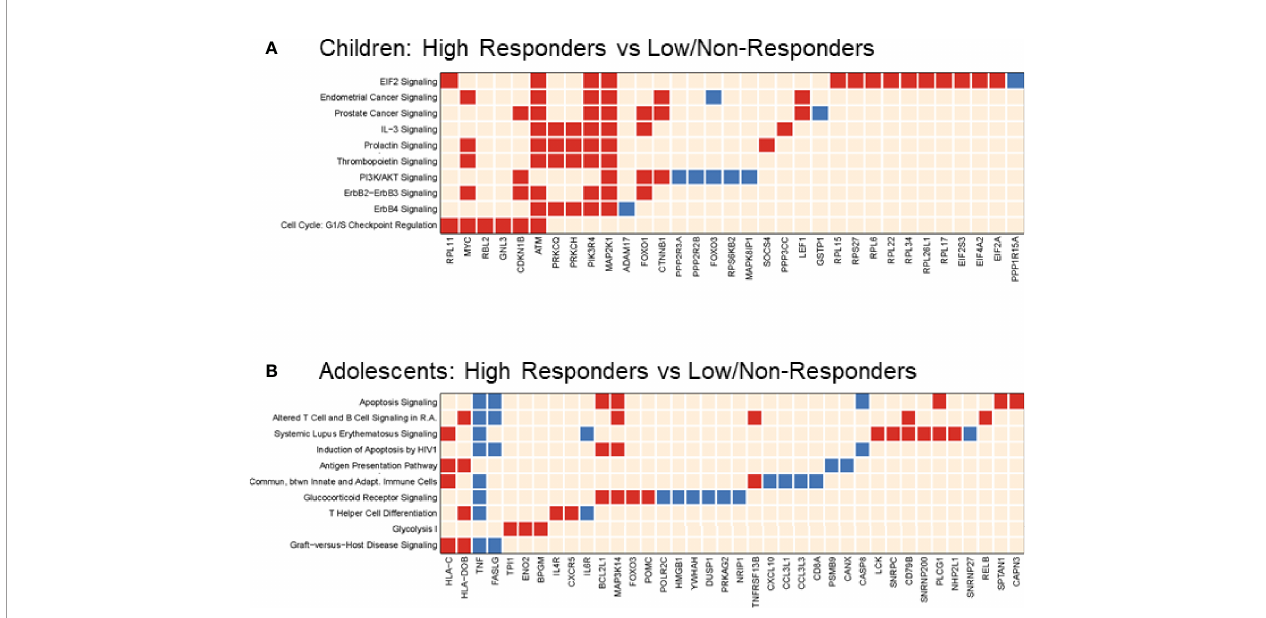
FIGURE 6 | Pathways Analysis in two Age Groups at Post-Vaccination. Top 10 (or top selected) signi fi cant pathways and their gene members enriched when comparing high responder versus low/non-responder at Visit 1 in 4-12yr group (A) and 13-24yr group (B) . Each row is a regulated canonical pathway (ingenuity software); each column represents an up-(red) or down-(blue) regulated genes (p-value <= 0.05 and |FC|>1.3) induced in 1 or more pathways(s). Over representation test was performed using Fisher Exact Test; signi fi cance, displayed on the right, is achieved for p<0.05 (-log(p)1.3).